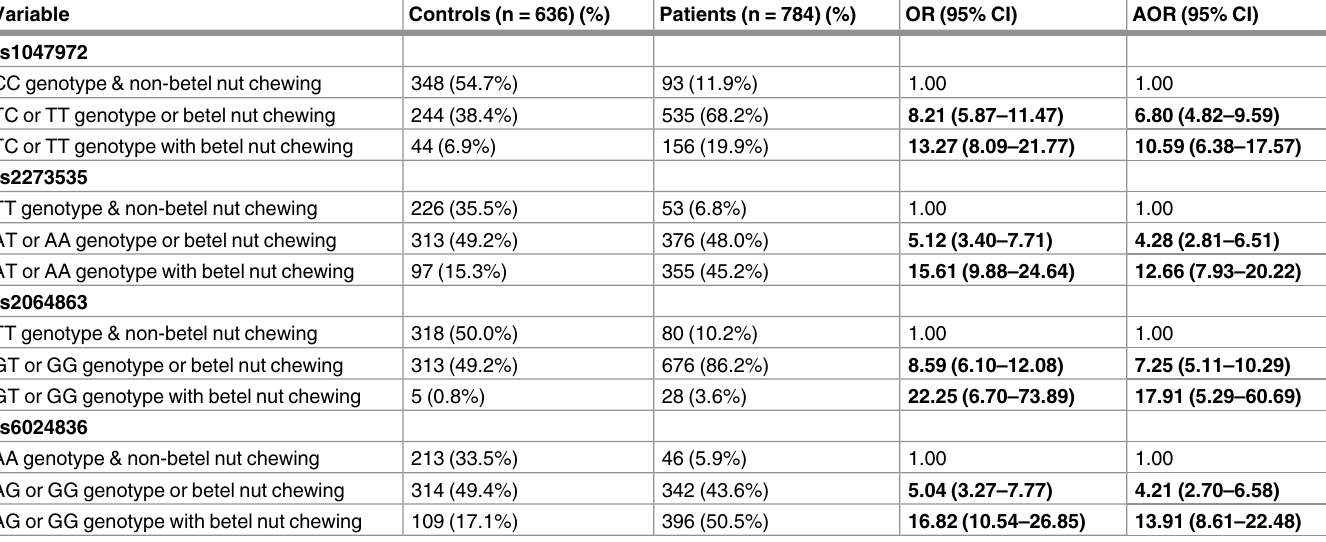
Table 3. Associations of the combined effect of AURKA gene polymorphisms and betel nut chewing with the susceptibility to oral cancer among 1420 smokers. Variable